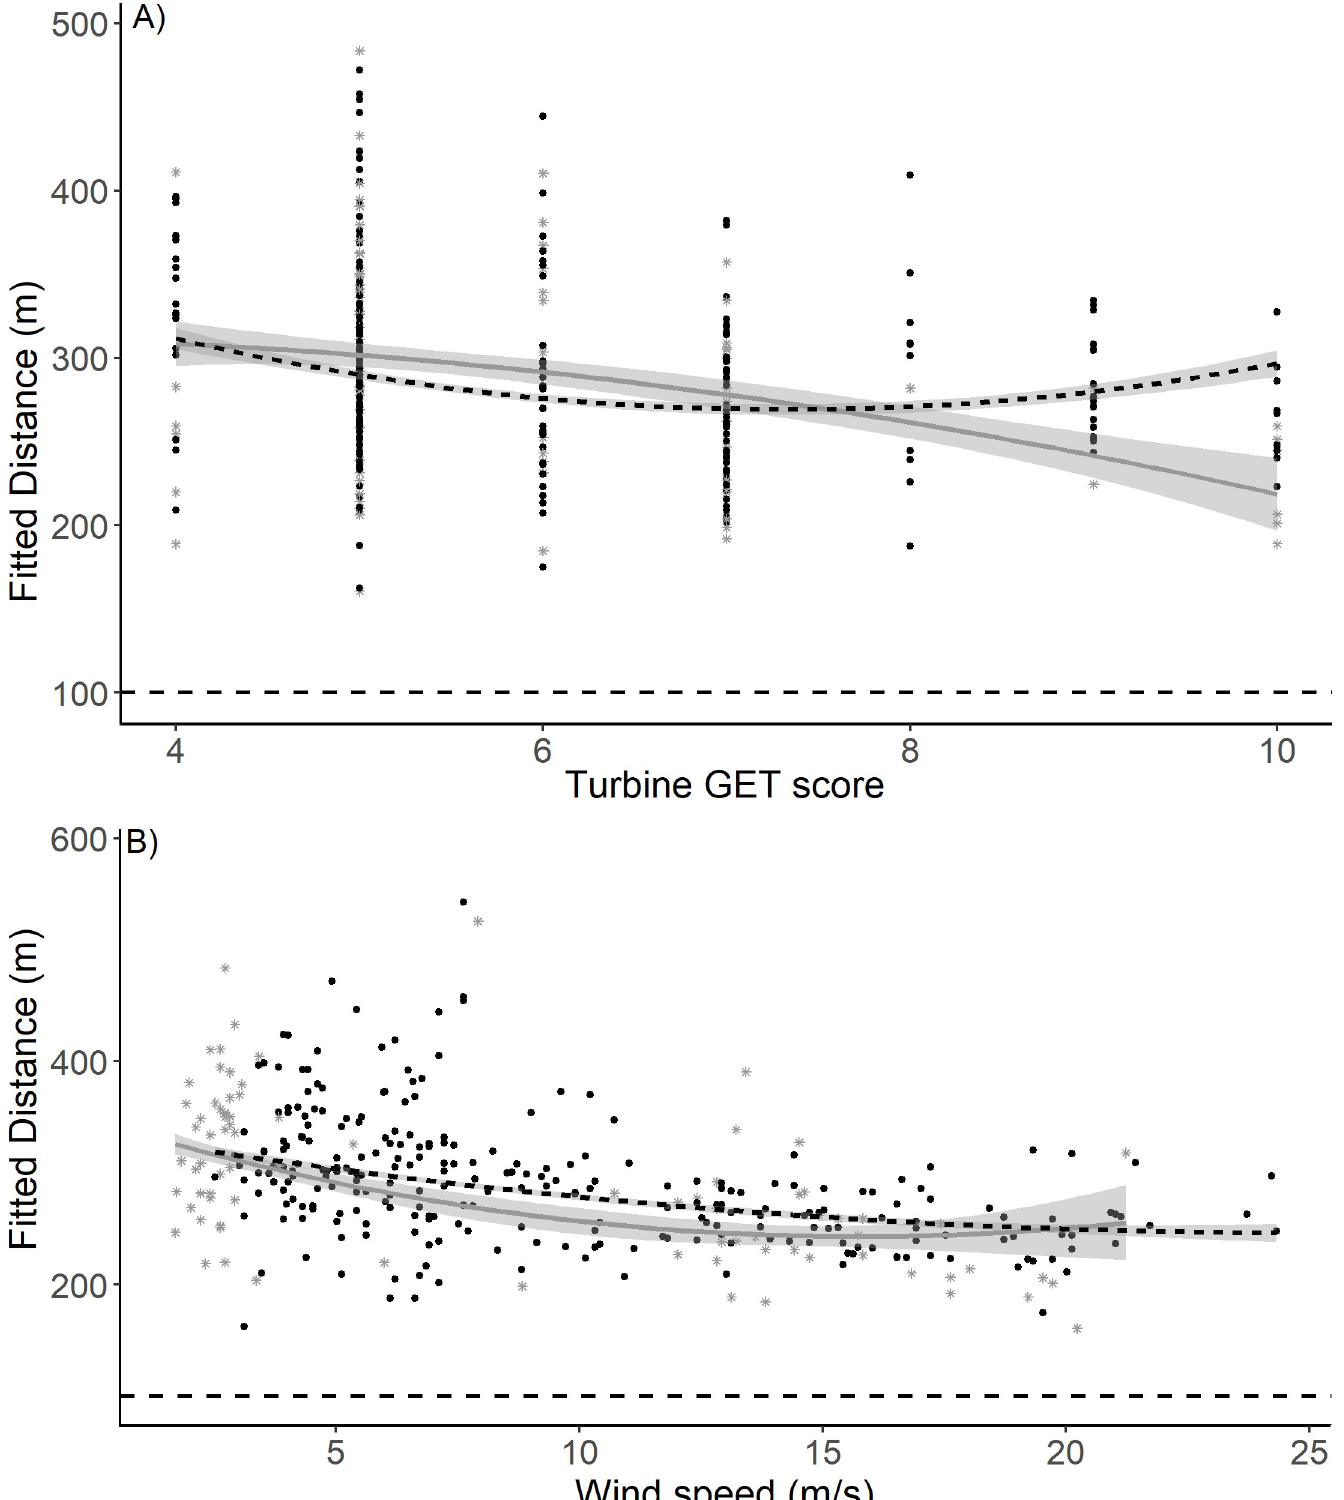
Fig 5. Relationships according to the best after-operation GLMM (Model 24: Tables 3 and 4) between: a) GET score (habitat preference increasing with score) at a turbine and fitted distance of an eagle flight line to a turbine hub, for turbines with moving blades (black dots, black short-dashed mean trend line) or